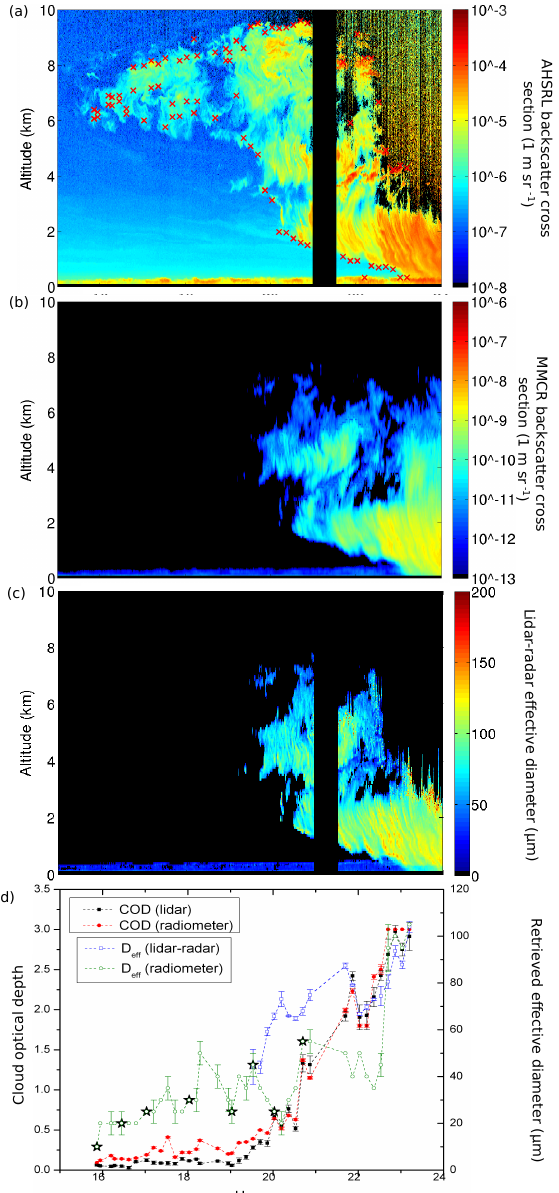
Figure 6. Evolution of validation and retrieval cloud parameters during a particular precipitating cloud event (13 January 2009) at Eureka. The error bars of the bottommost graph represent the re- trieval errors. The error for the lidar COD retrievals is sufficiently small to be obscured by the size of the symbols representing this component. The red crosses in the uppermost plot are the cloud boundary limits used as input to our method. The points upon which a star has been superimposed satisfied the criteria defined at the be- ginning of Sect. 6.2 and are thus an example of points accepted in the validation part of this